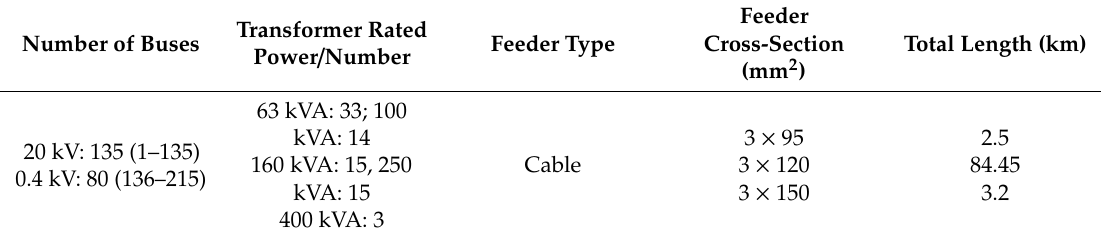
Table 6. The physical characteristics of the 215-bus EDN.